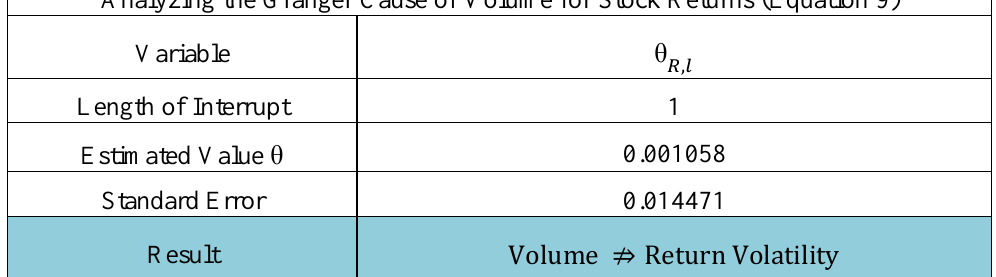
Table 4. The Estimation Results of the Conditional Variance Equation Analyzing the Granger Cause of Volume for Stock Returns (Equation